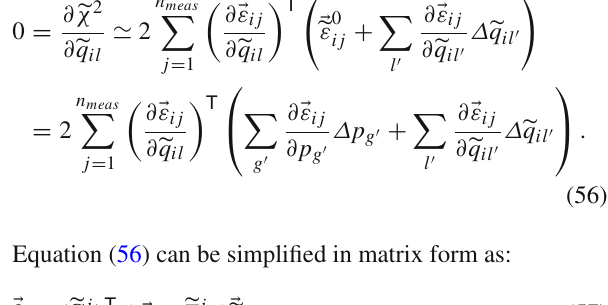
Fig. 18 Thestandarddeviationofthedifferenceintheinverserigidities measured using the upper span (L1–L8) and using the lower span (L2– L9) of the tracker, σ( 1 / R 18 − 1 / R 29 ), for cosmic-ray helium data with thealignmentcorrections(fullcircle)andfortheMonteCarloprediction based on the alignment errors of L1 and L9 (line) in the rigidity range R 19 > 570 GV. As seen, the data point best matches the Monte Carlo prediction at the alignment errors of 7.1 µ m and 7.9 µ m for L1 and L9 respectively